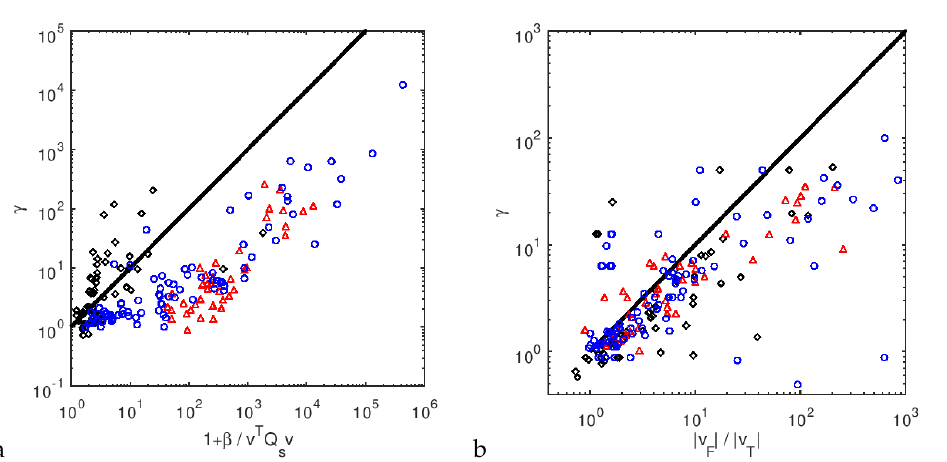
Figure 11. Collective plot for all considered datasets (blue circles—L547449, red triangles—L547785, black diamonds—L552177): ( a )—experimental scaling factor γ vs the theoretical derived from Briggs model, ( b )—experimental scaling factor γ vs. ratio of estimators magnitude | v F | / | v T | .